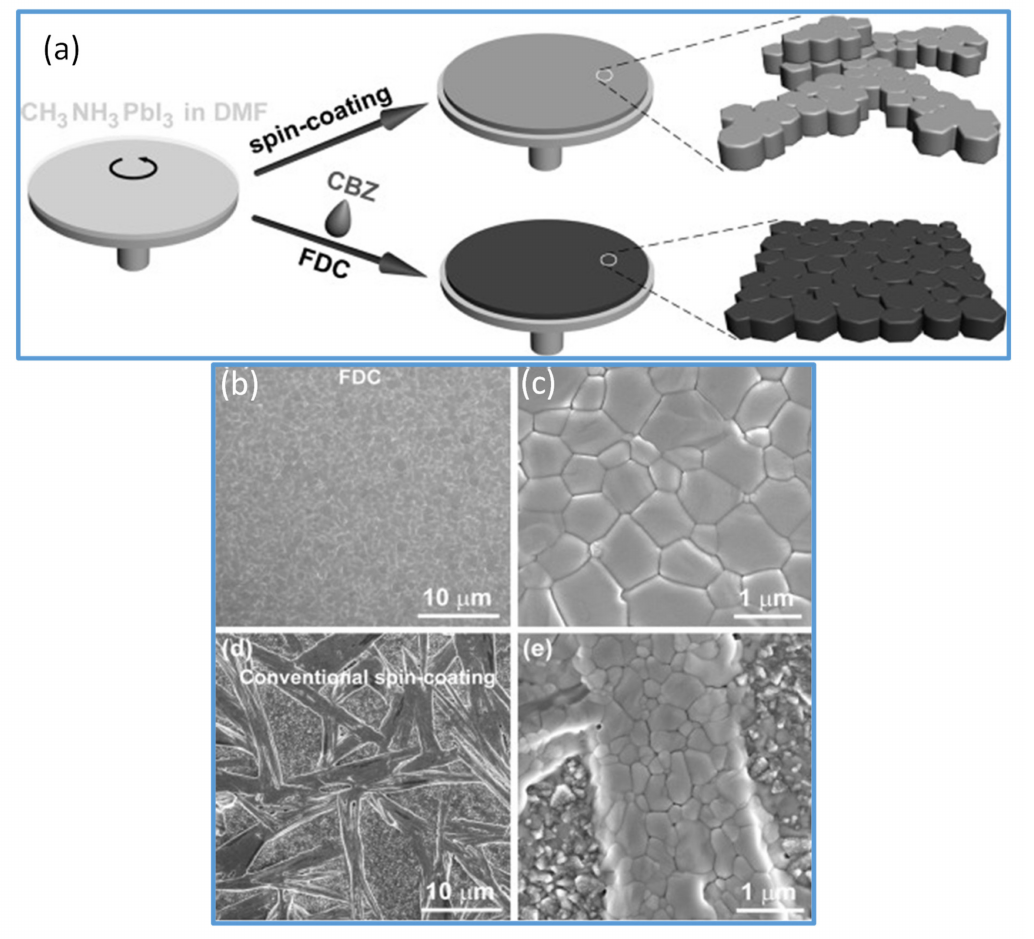
Figure 2. ( a ) Represents the spin-coating process and the FDC process to fabricate perovskite films. Spin coating (top) produces a shiny gray film with nonuniform large crystals. A second solvent (CB) is dripped on the wet film during the spin coating to induce fast crystallization producing the uniform size perovskite grains. ( b , c ) SEM images of CH 3 NH 3 PbI 3 film fabricated by FDC process using antisolvent (CB). ( d , e ) SEM images of a film fabricated by conventional spin coating. Reproduced with the permission from ref. [61], Copyright 2014, Agewandte Intl. Ed. Chemie